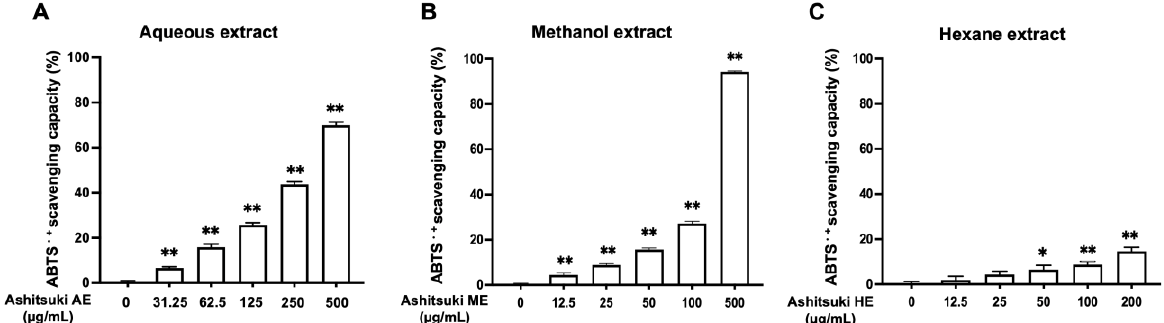
Figure 3. Anti-oxidant activity of N. verrucosum ( ashitsuki ) extracts. Anti-oxidant activity of N. verrucosum aqueous ( A ), methanol ( B ), and hexane ( C ) extracts were measured using the assay of ABTS radical scavenging activity. Results are represented as ABTS radical scavenging activity (%); the data are shown as mean ± SEM of three separate experiments. * p < 0.05, ** p < 0.01 versus the control group.